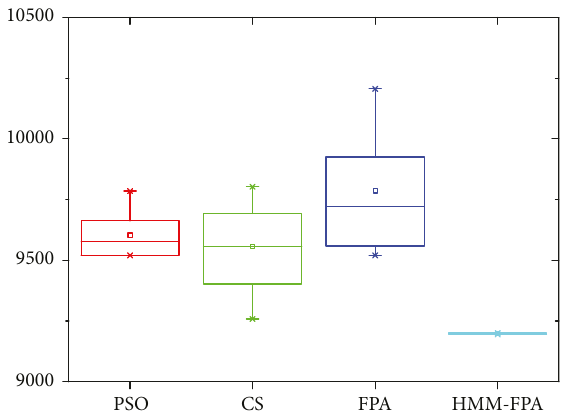
Figure 7: ANOVA tests of Car4.